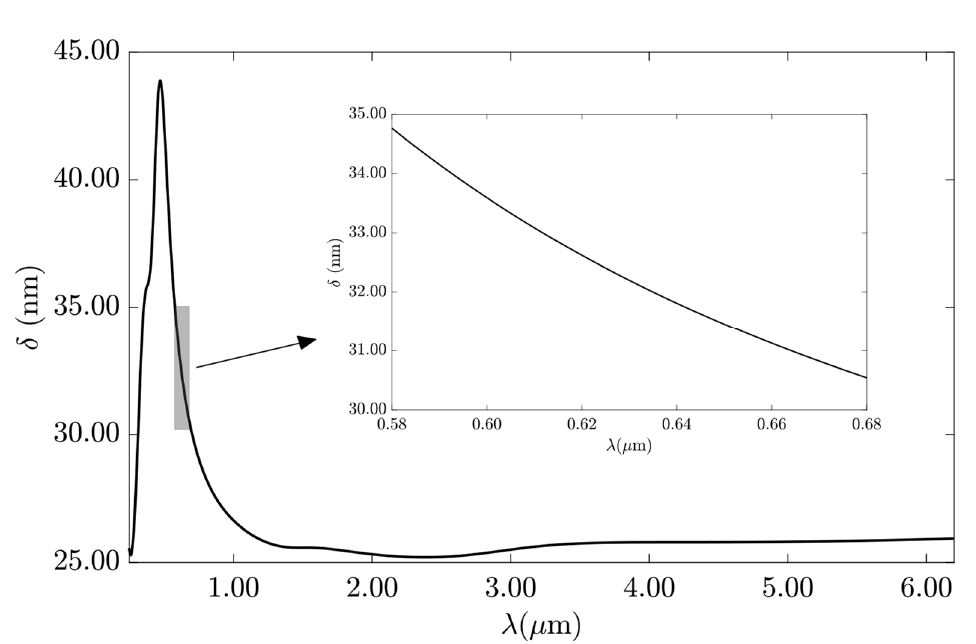
Figure 5. The skin depth penetration for gold at the optical frequency range. Inset: closeup of the region from 0.58 to 0.68 μ m.